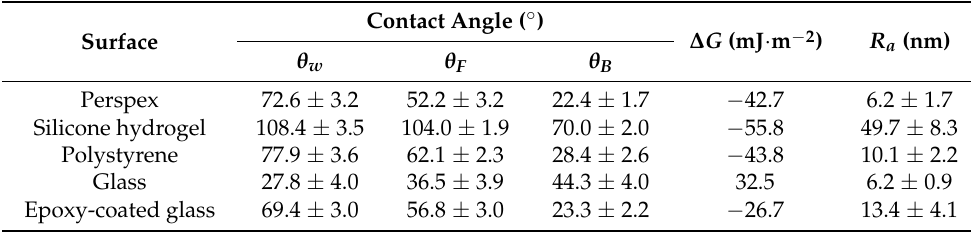
Table 1. The contact angles with water ( θ w ), formamide ( θ F ), and α -bromonaphthalene ( θ B ), hy- drophobicity (according to Equation (4)) ( ∆ G ), and roughness ( R a ) determined for the tested surfaces. Values are presented as the mean ± standard